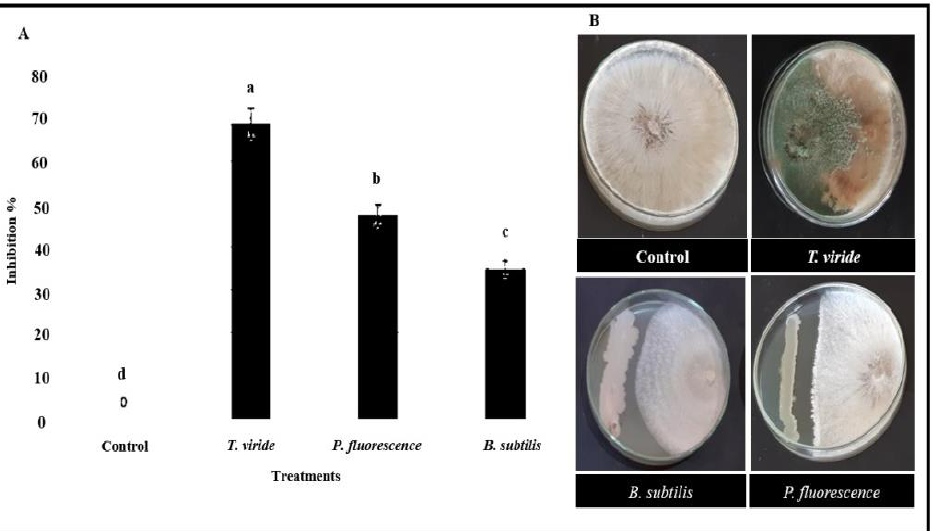
Figure 3. The antagonism between T. viride , P. fluorescence , and B. subtilis and the pathogenic fungi R. solani as an inhibitory percentage ( A ), different letters indicate statistically significant differences among treatments, while the same letters signify no significant differences between them according to Tukey’s honestly significant difference test ( p < 0.05). No inhibition was observed in non-treated R. solani compared with noticeable inhibition of the mycelium growth by T. viride , P. fluorescence , and B. subtilis ( B ).